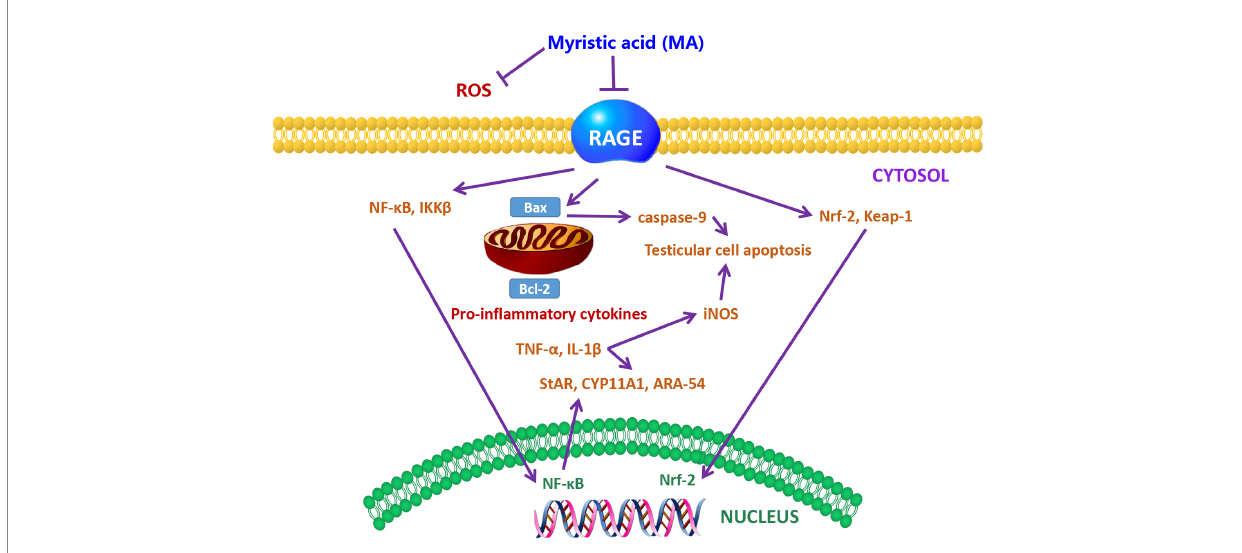
FIGURE 4 The protective mechanism of MA on sperm (128). Schematic showing the mechanism of MA protection in the testis. MA may lead to the down- regulation of RAGE and the reduction of ROS levels. Meanwhile, MA may also prevent the increase of lipid peroxidation and antioxidant enzymes by reducing the alteration of Nrf2-Keap1 pathway. MA treatment has also been postulated to have the ability to inhibit the NF-k β pathway, resulting in the down-regulation of NF-k β and IKKB, and thus possibly the reduction of TNF- α , IL-1 β , and iNOS levels. In addition, MA can also prevent apoptosis by down-regulating the expression of Bax. MA treatment helps to increase the levels of steroidogenic markers such as StAR, CYP11A1 and ARA-54 in the testis of